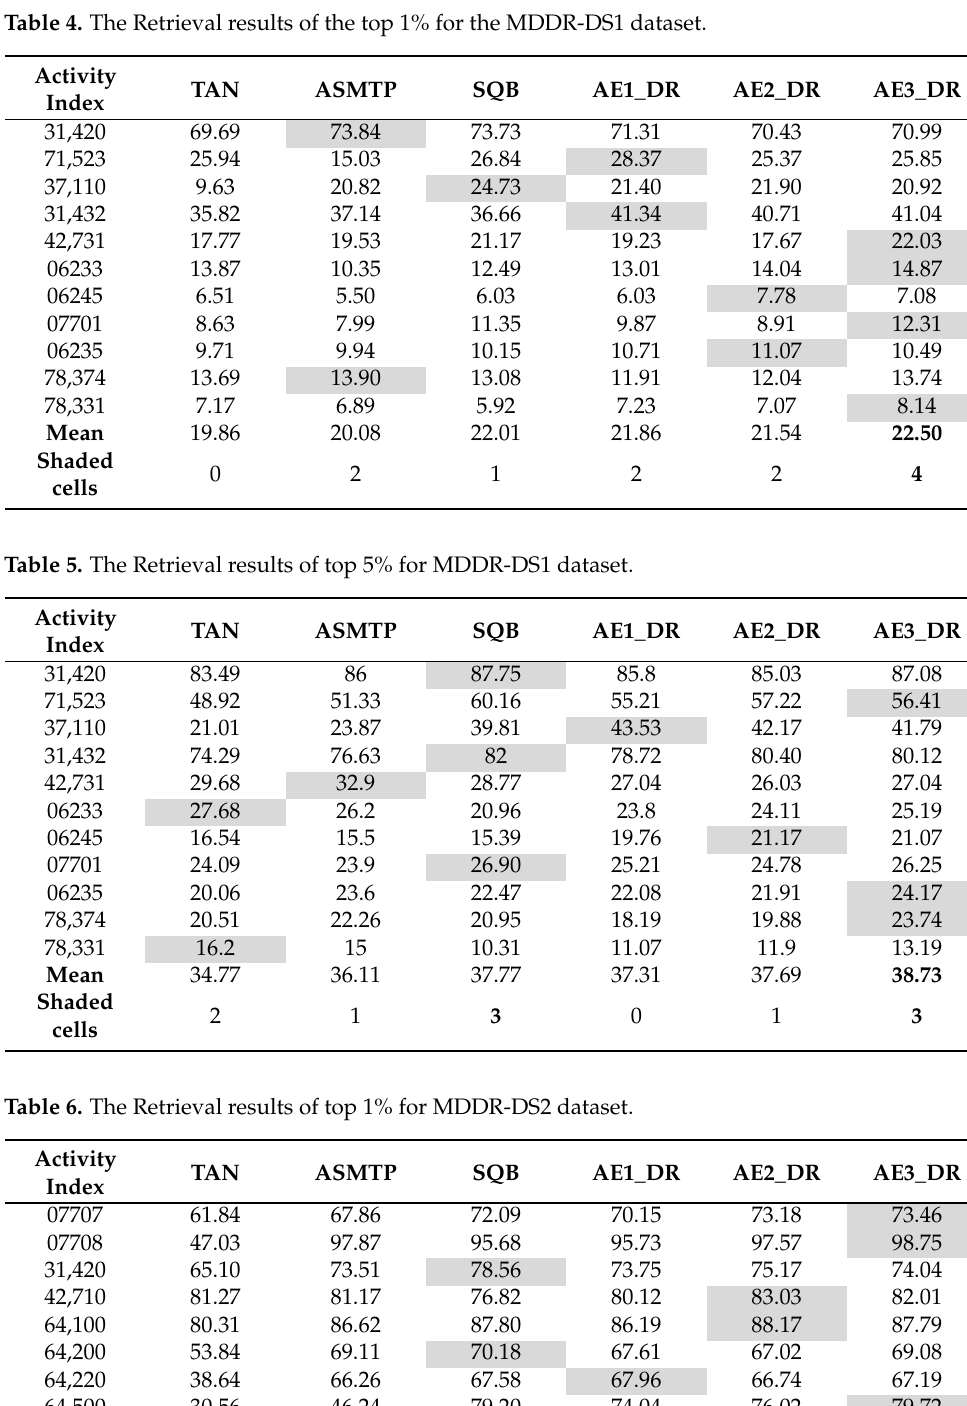
Table 4. The Retrieval results of the top 1% for the MDDR-DS1 dataset.